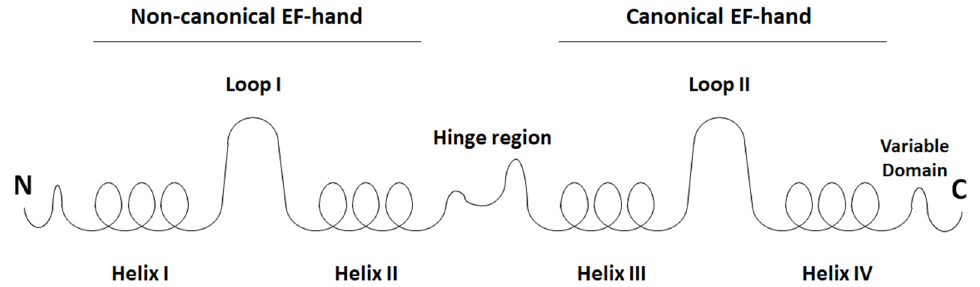
Figure 3. Schematic representation of the S100 protein secondary structure. Each calcium-binding loop (Loop I and Loop II) is flanked by α -helices (Helix I and II for Loop I and Helix III and IV for Loop II). The non-canonical N-terminal EF-hand has approximately 100-fold lower affinity to bind calcium than the canonical C-terminal EF-hand. The hinge region links Helix II with Helix III. C-terminal EF-hand is followed by a C-terminal extension, which is variable among S100 proteins and together with the hinge region have a crucial role in the interaction of each S100 protein family member with specific target proteins.